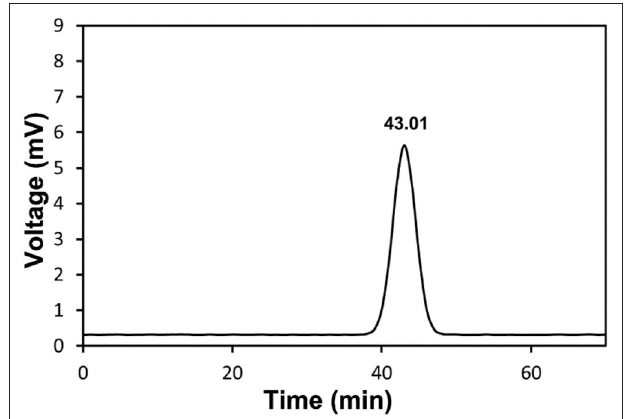
FIGURE 1 | HPGPC chromatogram of RCHP-S.